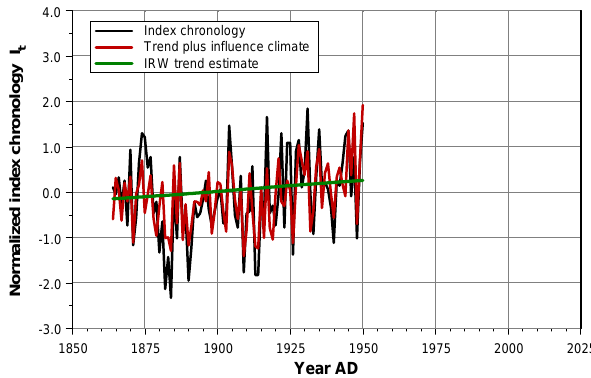
Fig. 4. Larch data, standardized by RCS, 1864–1950. In this ex- Fig. 4 Larch data, standardized by RCS, 1864-1950. In this example we re-estimated the results 2 ample we re-estimated the results shown in Fig. 3. The response shown in Fig. 3. The response weight appears to be constant: a ˆ = 0.70 – 0.15. The explained variance 3 weight appears to be constant: ˆ α =0.70 ± 0.15. The explained vari- is 55%. The slightly increasing linear trend is statistically non-significant. 4 ance is 55%. The slightly increasing linear trend is statistically non-